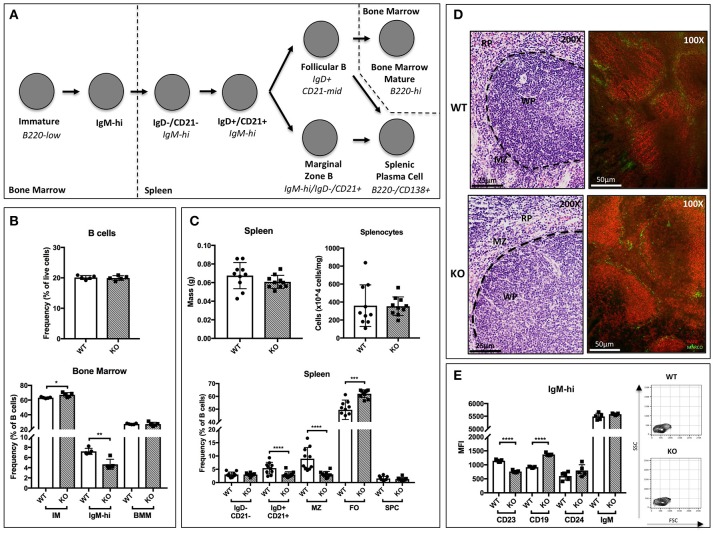
B cell development in St6gal1-KO mice. St6gal1-KO (KO) mice were backcrossed onto a C57BL/6J (WT) background for 15 generations to control for strain-specific differences. (A) Schematic of B cell development from the immature to mature stages in the bone marrow and spleen, as proposed by Carsetti and colleagues. (B) Frequency of B cells in the bone marrow (upper panel) and B cell subpopulations (lower panel) in WT and KO mice (n = 5). (C) Splenic mass and cell counts in WT and KO mice (upper panels). Frequencies of splenic B cell subpopulations in WT and KO mice (lower panel; n = 10). (D) Hematoxylin and eosin-stained spleens, with location of relevant anatomical compartments (WP, white pulp; RP, red pulp; MZ, marginal zone). Immunofluorescence microscopy of B220 (red) and marginal zone marker MARCO (green). (E) Mean fluorescence intensity of cell surface CD19, CD24, IgM, and CD23 in IgM-high bone marrow B cells, with FSC and SSC of gated cells shown (n = 5). *P < 0.05, **P < 0.01, ***P < 0.001, ****P < 0.0001.